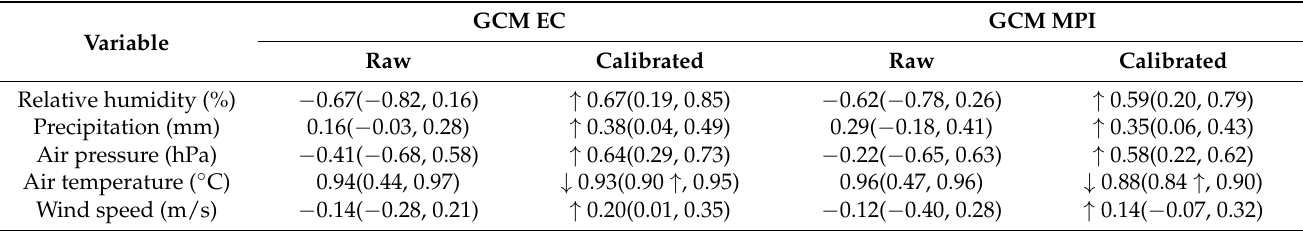
Table 2. Stats of Pearson’s correlation coefficient ( r ) at the 36 QTP sites before (Raw) and after (Calibrated) the first adjustment (1985–1999) based on two GCM simulations (EC and MPI). The coefficients are measured against the observations. The medians ahead the parentheses, and the minima and maxima within the parentheses. The upward and downward arrows indicate the gain and loss in r from the adjustment compared to the raw simulations. N = 180 for each site. GCM EC GCM MPI Variable Raw Calibrated Raw Relative humidity